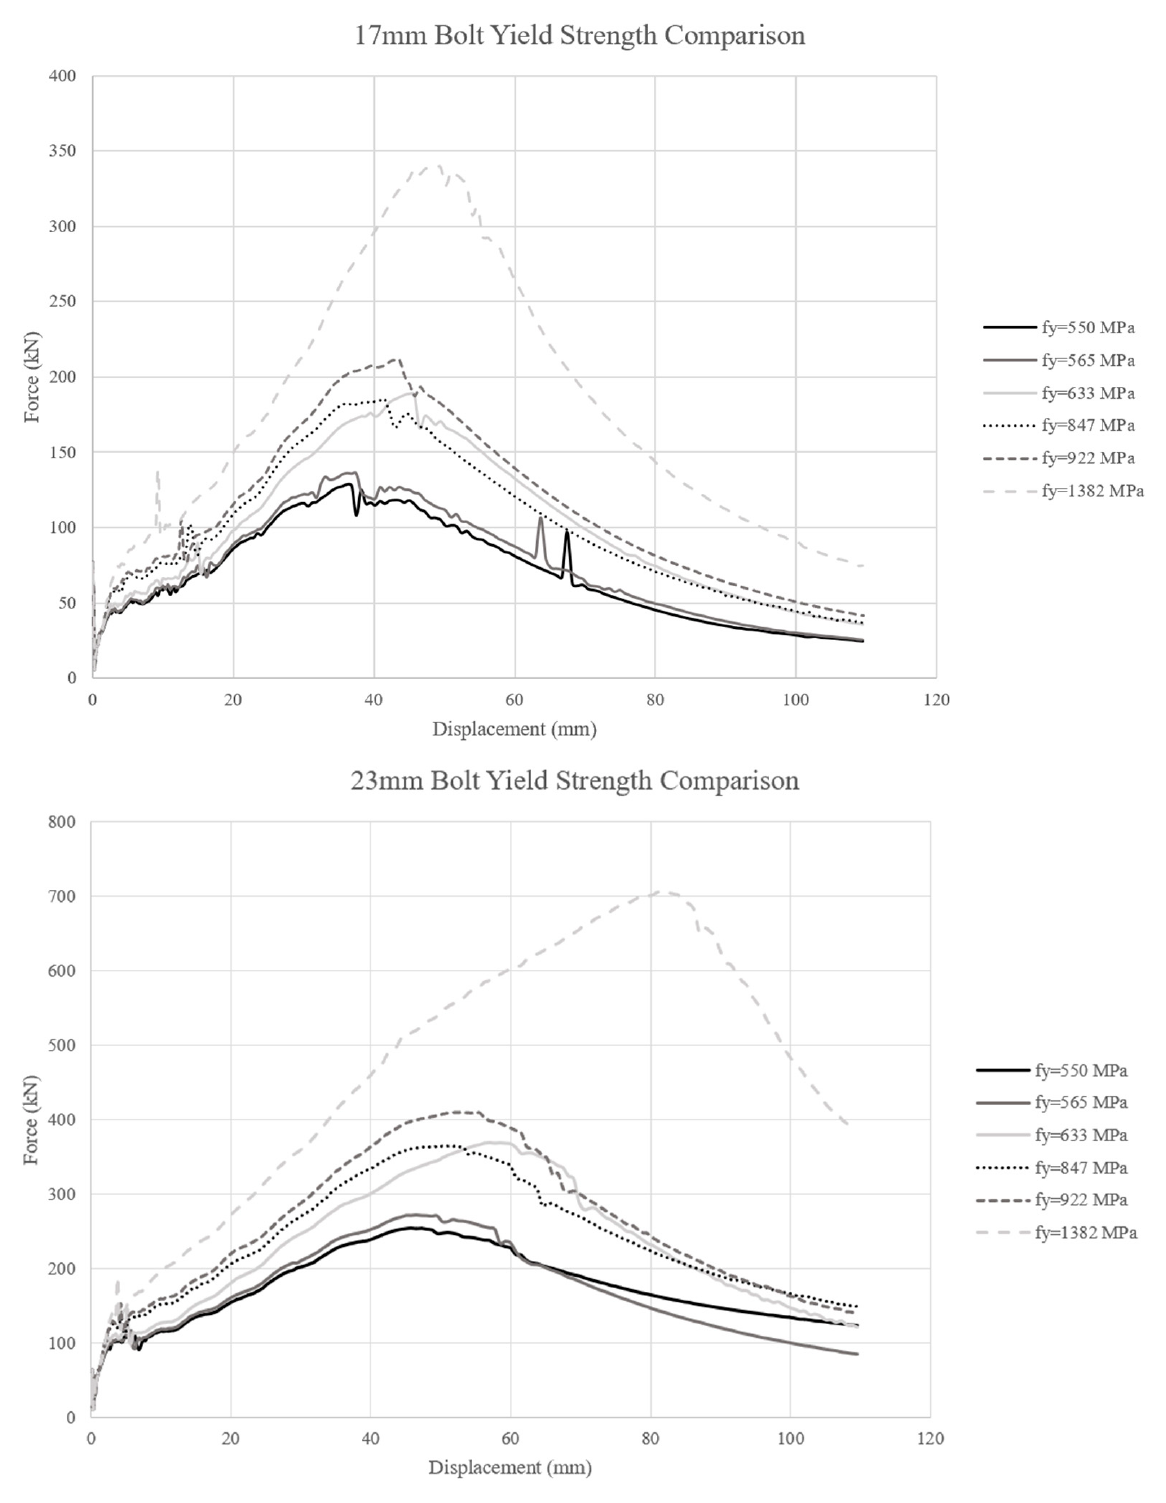
Figure 12. Comparison of 18 mm bolt ( top ) 23 mm bolt ( bottom ).